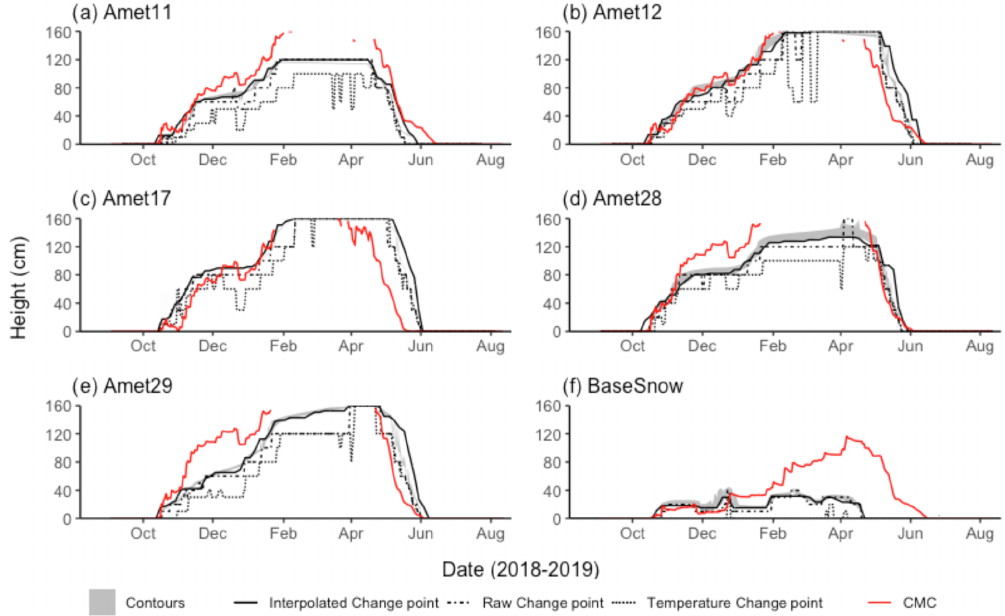
Figure 12. Comparison of snow depths derived with light and temperature-based methods and Canadian Meteorological Centre (CMC) snow depth analysis data (Brown and Brasnett, 2003) for (a) Amet11, (b) Amet12, (c) Amet17, (d) Amet28, (e) Amet29 and (f) BaseSnow. Snow depth estimates are provided for interpolated contours using minimum and maximum snow cover thresholds (grey shading), interpolated change-point analysis (black line), raw change-point analysis (dot-dashed line), temperature change-point analysis (dotted line) and modelled CMC snow depth at the associated grid cell (red line).